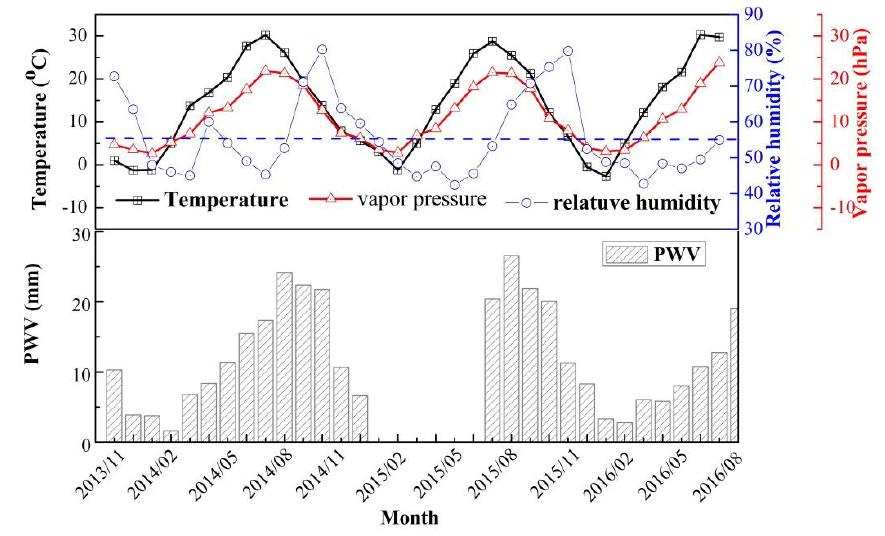
Figure 10. The seasonal variation trends in PWV and ground meteorological elements.